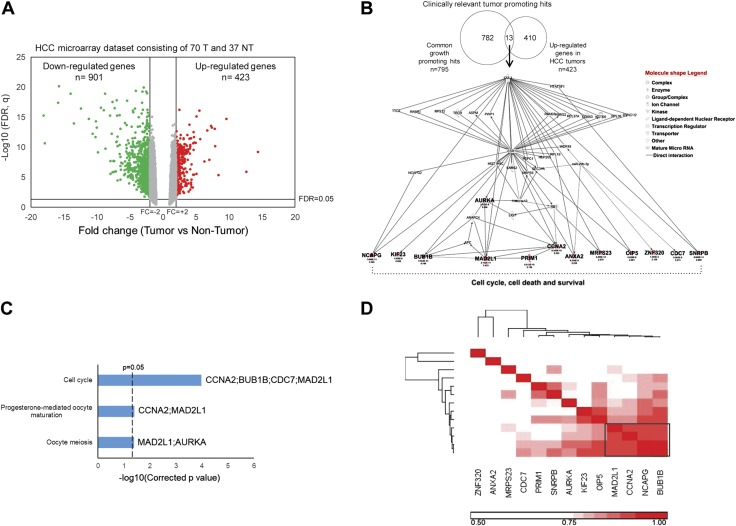
The clinically relevant targets from the CRISPR screen are enriched in the cell cycle pathway. A) Volcano plot showing significantly overexpressed genes (red) and underexpressed genes (green) between 70 HCC tumors and 37 nontumor samples. Significantly differentially expressed genes were indicated in the 2 upper lateral quadrants with absolute FC >2 and q < 0.05. B) Top: Venn diagram showing 13 clinically relevant targets by overlapping 795 common hits from the depletion screen with 423 significantly overexpressed genes in HCC tumors. Bottom: ingenuity pathway analysis showing all 13 clinically relevant targets (in bold) that participated in the interplay of cell cycle and cell death and survival networks. C) KEGG pathway enrichment analysis showing significant enrichment in cell cycle among the 13 clinically relevant targets. D) Pearson correlation matrix of the 13 clinically relevant targets showing a tight cluster of MAD2L1, CCNA2, NCAPG, and BUB1B (black box) in the HCC microarray dataset shown in A. ANXA2, annexin A2; APC, adenomatous polyposis coli; ASPM, abnormal spindle microtubule assembly; AURKA, aurora kinase A; CDC7, cell division cycle 7; CUL3, Cullin 3; DDX50, DExD-box helicase 50; DYNC1I2, dynein cytoplasmic 1 intermediate chain 2; ESR1, estrogen receptor 1; HIST1H4C, histone cluster 1 H4 family Member C; HTATSF1, HIV-1 tat specific factor 1; KIF23, kinesin family member 23; LIG1, DNA ligase 1; KCTD6, potassium channel tetramerization domain containing 6; MRPS9, mitochondrial ribosomal protein S9; NT, nontumor; NUP205, nucleoporin 205; OIP5, Opa interacting protein 5; PRIM1, DNA primase subunit 1; PSPC1, paraspeckle component 1; PWP1, PWP1 homolog, endonuclein; RB1, RB transcriptional corepressor 1; RBM, RNA binding motif protein; RPL, ribosomal protein L; RPS12, ribosomal protein S12; RRBP1, ribosome binding protein 1; SARS2, seryl-TRNA synthetase 2; SEC31A, SEC31 homolog A, COPII Coat Complex component; SNRPB, small nuclear ribonucleoprotein polypeptides B and B1; T, tumor; TECR, trans-2,3-enoyl-CoA reductase; TTC5, tetratricopeptide repeat domain 5; WDR18, WD repeat domain 18; ZNF320, zinc finger protein 320.